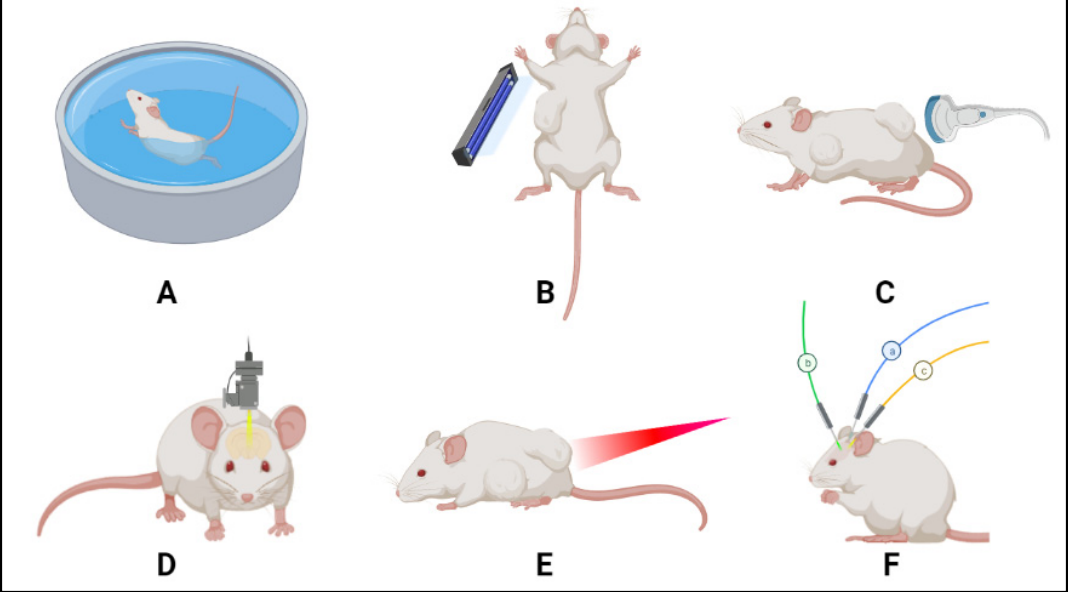
Figure 9. Different heating modalities for triggering release from TSLs: ( A ) water bath, ( B ) cold lamp, ( C ) US, ( D ) laser, ( E ) microwave radiation, and ( F ) interstitial methods (e.g., radiofrequency).